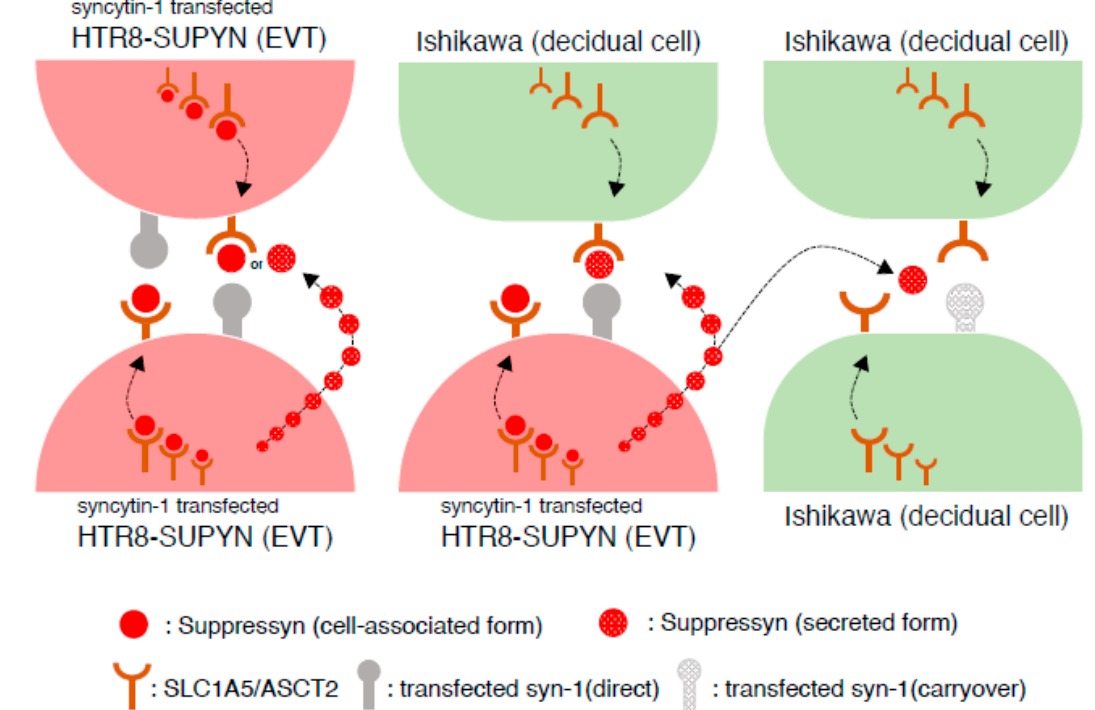
Figure 4. Mechanism of SUPYN interaction with SLC1A5/ASCT2 in allogenic and heterogenic cells. Three types of the many possible decidual cell interactions in the human decidua that are modeled by our in vitro experiments are illustrated: EVT-EVT (left), EVT-decidual epithelia or decidual stroma (decidua) and (middle) and decidual-decidual (right). In EVT-EVT homotypic fusion seen as red-colored, multinuclear HTR8 homotypic fusion (Figure 3), it is likely that SUPYN forms a heterotypic protein complex with SLC1A5 in the HTR8 cell cytoplasm and suppresses normal receptor-binding with syn1 expressed on the cell surface of a partner HTR8 cell. In EVT-decidual epithelial cell heterotypic fusion, seen as orange-colored multinuclear HTR8-Ishikawa heterotypic cell fusion in Figure 3, green Ishikawa cells do not endogenously express SUPYN, and intracellular processing of SLC1A5 will not be affected by such interactions. However, secretory SUPYN protein is released from partner HTR8-SUPYN cells; binds to Ishikawa cell-expressed SLC1A5 and inhibit the profusogenic actions of syn1. In decidual epithelial cell homotypic fusion seen as green colored multinuclear Ishikawa homotypic fusion in Figure 3, green Ishikawa cells that express SLC1A5 should express neither syn1 nor SUPYN and therefore would not be predicted to undergo homotypic fusion. In our experiments, we hypothesize that such fusion was driven by inadvertent carryover of syn1-expressing plasmid during co-culture with transiently transfected HTR8 cells. We further suggest that this aberrant homotypic Ishikawa cell fusion was not blocked by SUPYN secreted from HTR8-SUPYN cells in co-culture due to an insufficient local SUPYN concentration at the site if Ishikawa-Ishikawa cell interactions. Symbols for cell-associated and secreted forms of SUPYN, transfected syn1 (direct and carryover) and SLC1A5 depicted in the diagram are identified at the bottom of the figure.